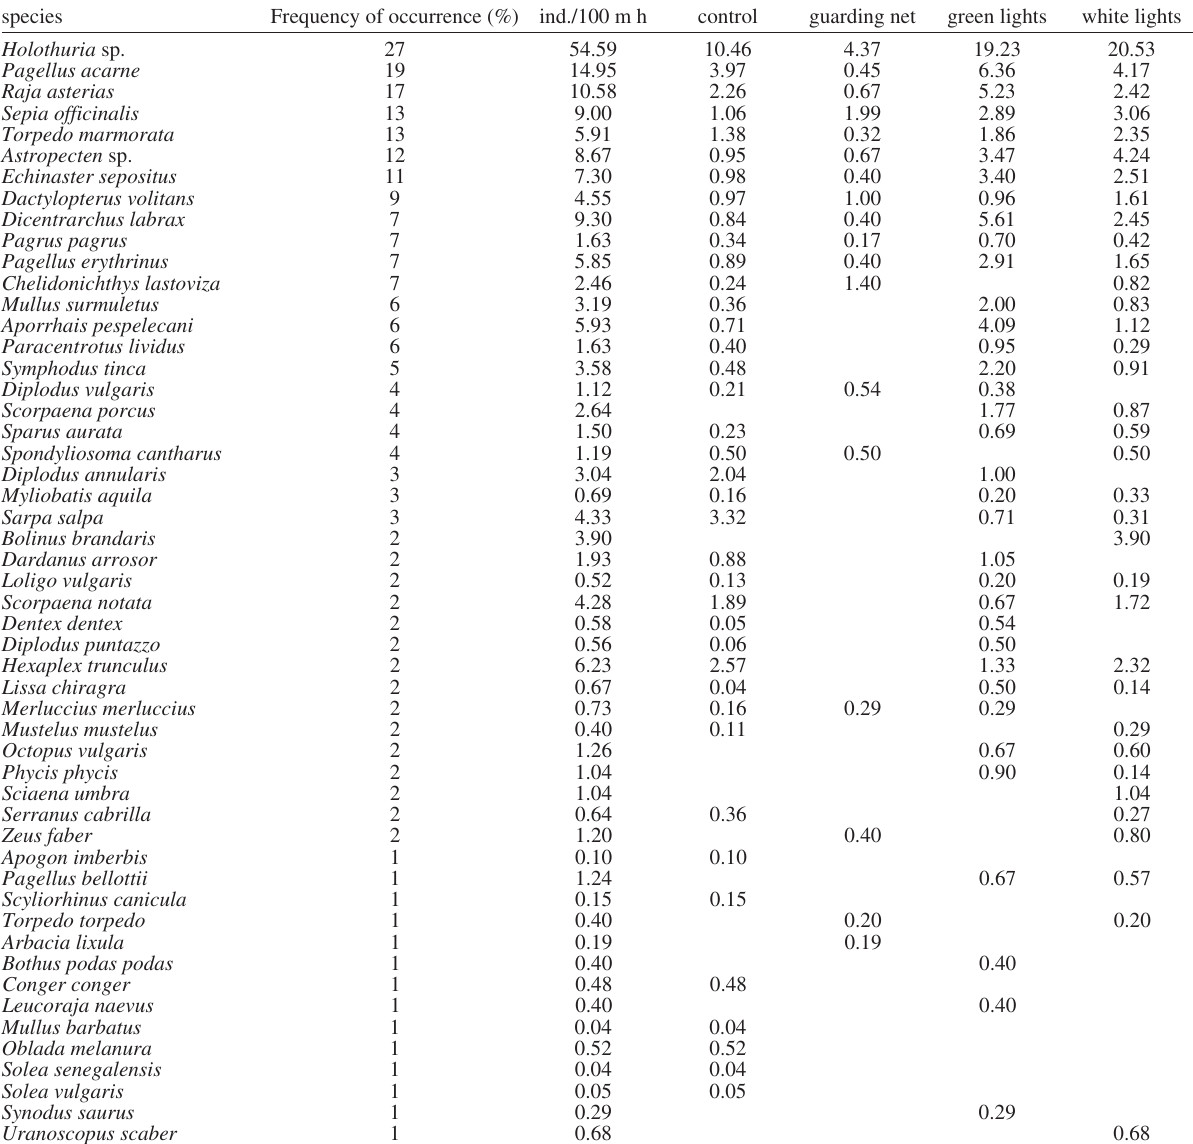
Table 2. – Standardized catch in numbers (ind./100 m h) and frequency of occurrence of unwanted catches (non-commercial species or undersize/damaged specimens of commercial species). species Frequency of occurrence (%) ind./100 m h control guarding net green lights white lights Holothuria